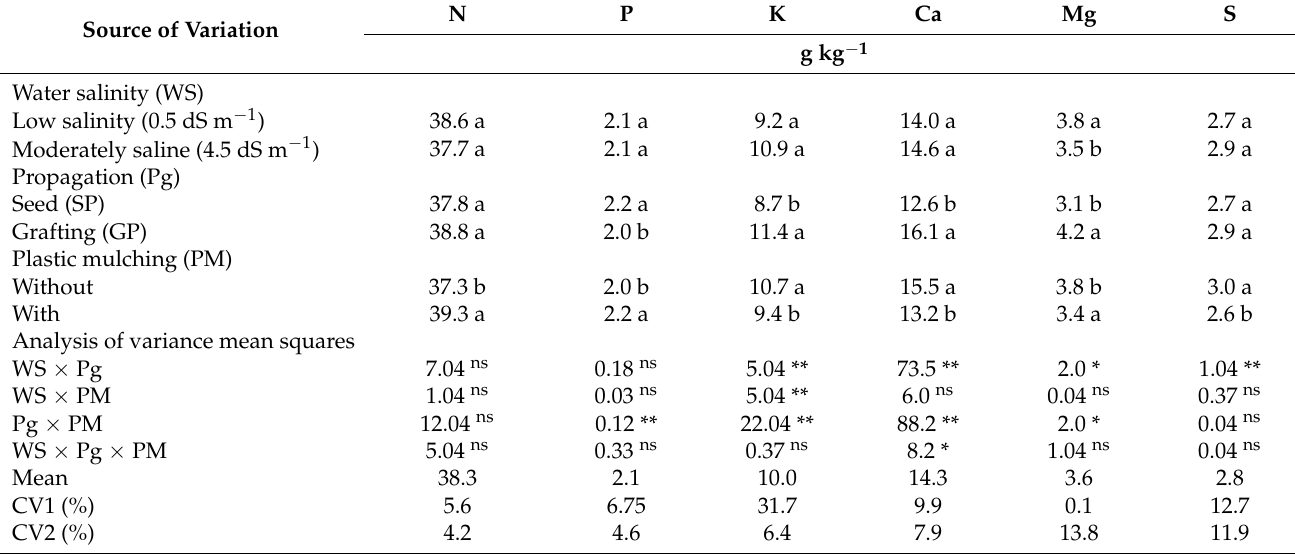
Table 1. Variance analysis summary and mean concentrations of nitrogen (N), phosphorus (P), potassium (K), calcium (Ca), magnesium (Mg), and sulfur (S) in sour passion fruit leaves as a function of water salinity (WS), plant propagation (Pg), and plastic mulching